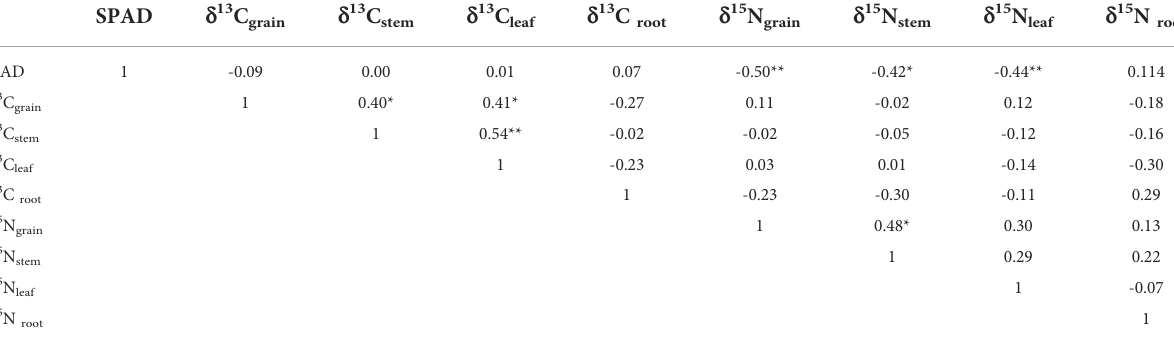
TABLE 2 Pearson correlation coef fi cients for SPAD reading, d 13 C values in grain, stem, leaf, and root, and d 15 N of grain, stem, leaf, and root.